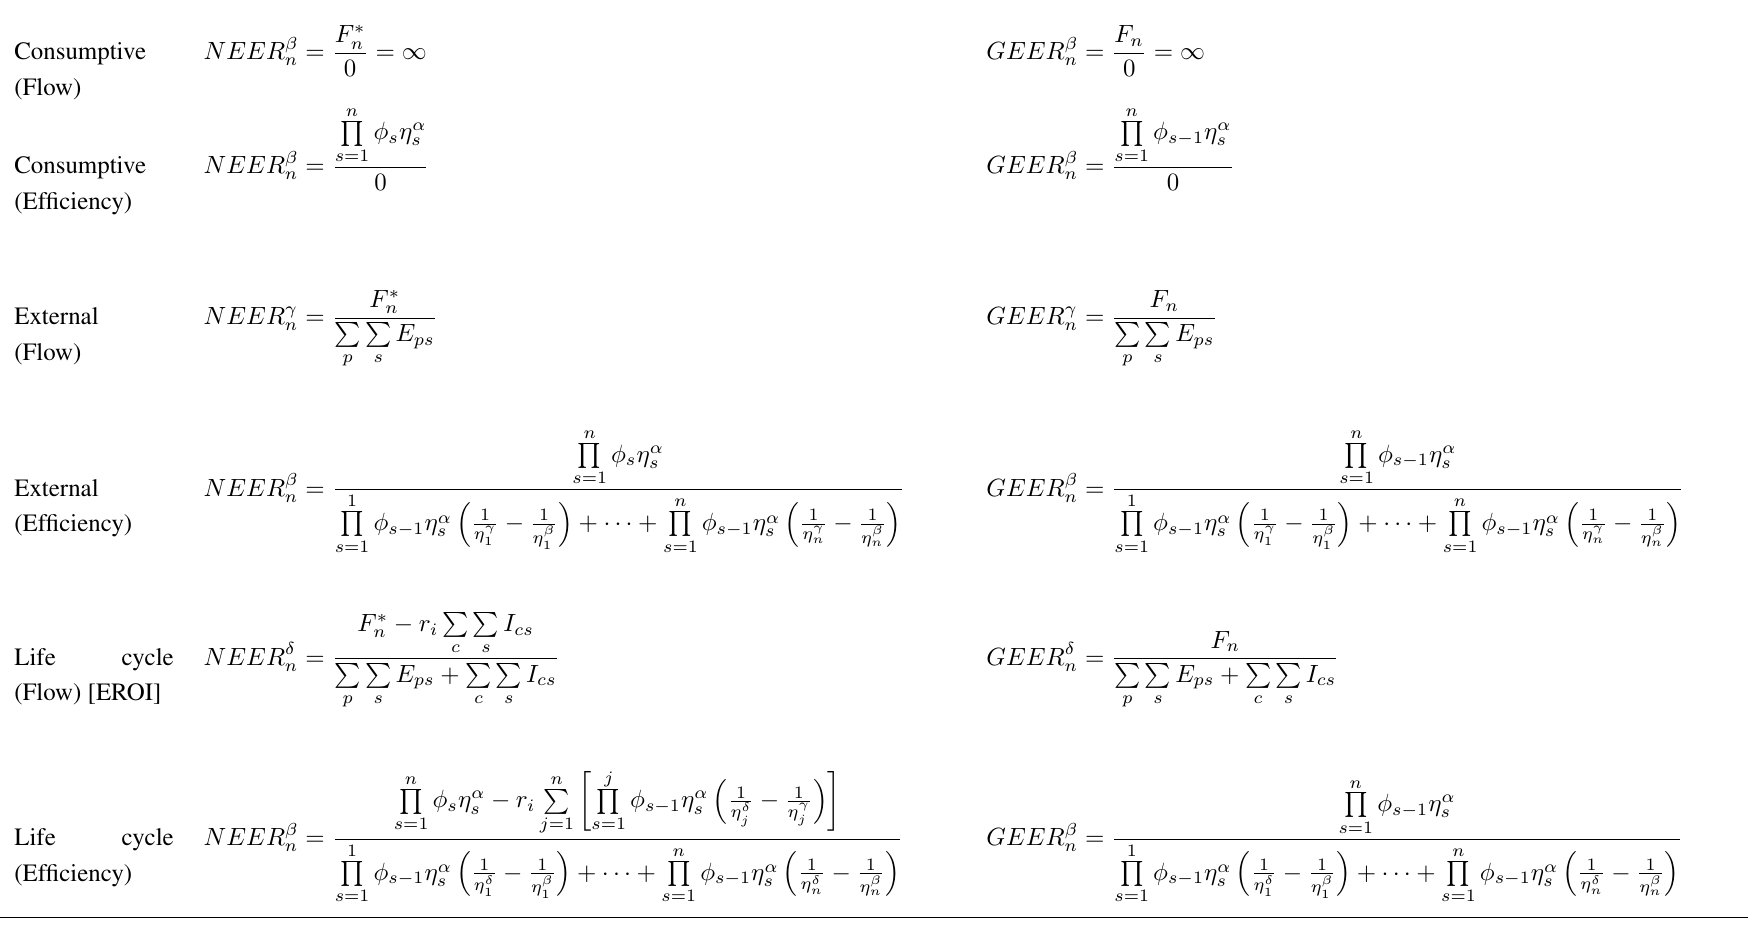
Table 2. NEER and GEER formulations based on flows of energy (flow-based) and process stage efficiencies (efficiency-based). ERR